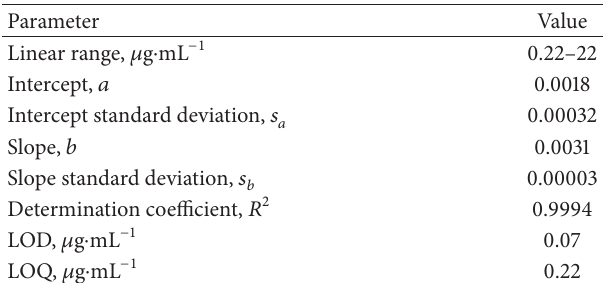
Table 1: Analytical parameters of the first-order derivative spectro- metric method for the indirect HQ